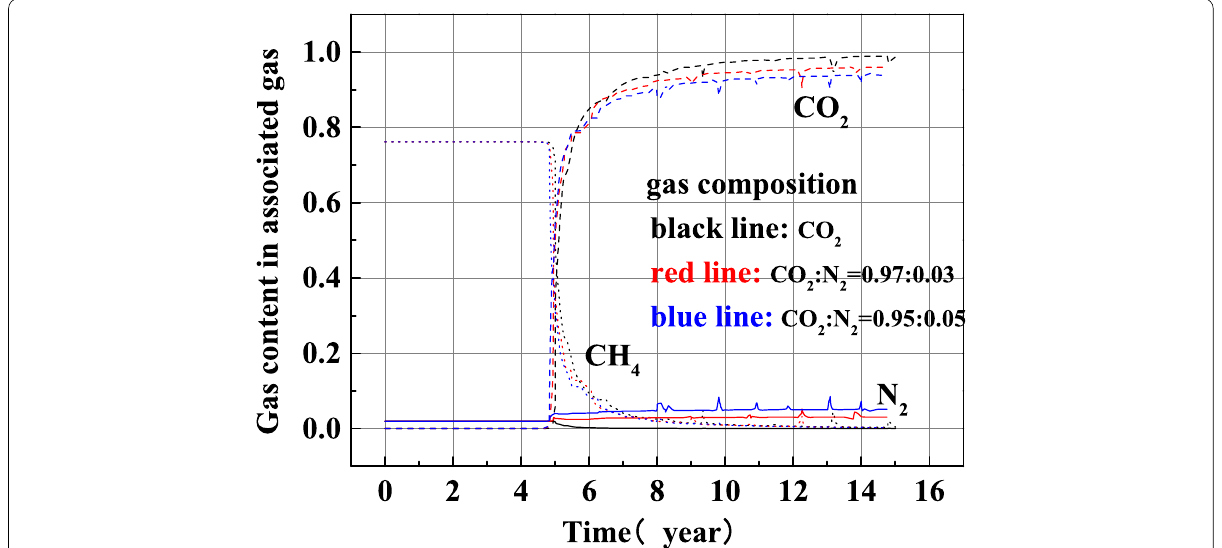
Fig. 2 Variations in the N 2 , CO 2 , and CH 4 contents of the produced gas with injection